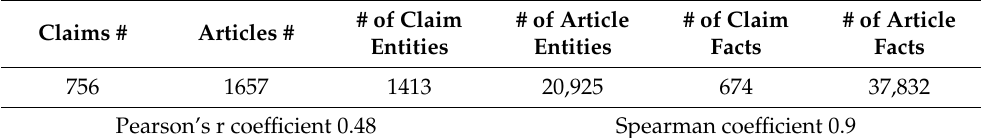
Table 2. Correlation measure